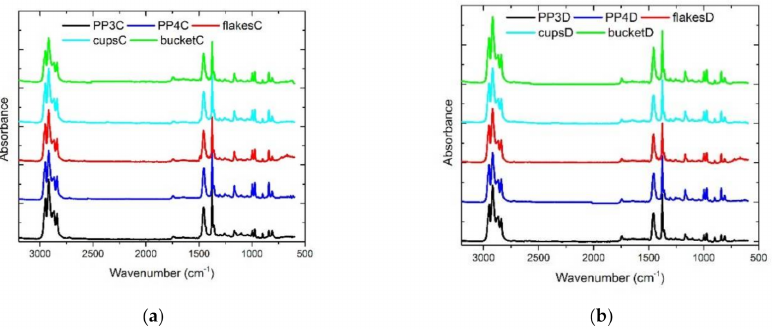
Figure 12. FTIR spectra of the blend series with LCB-PP ( a ) on basis of PODIC C126 and ( b ) on the basis of PEROXAN